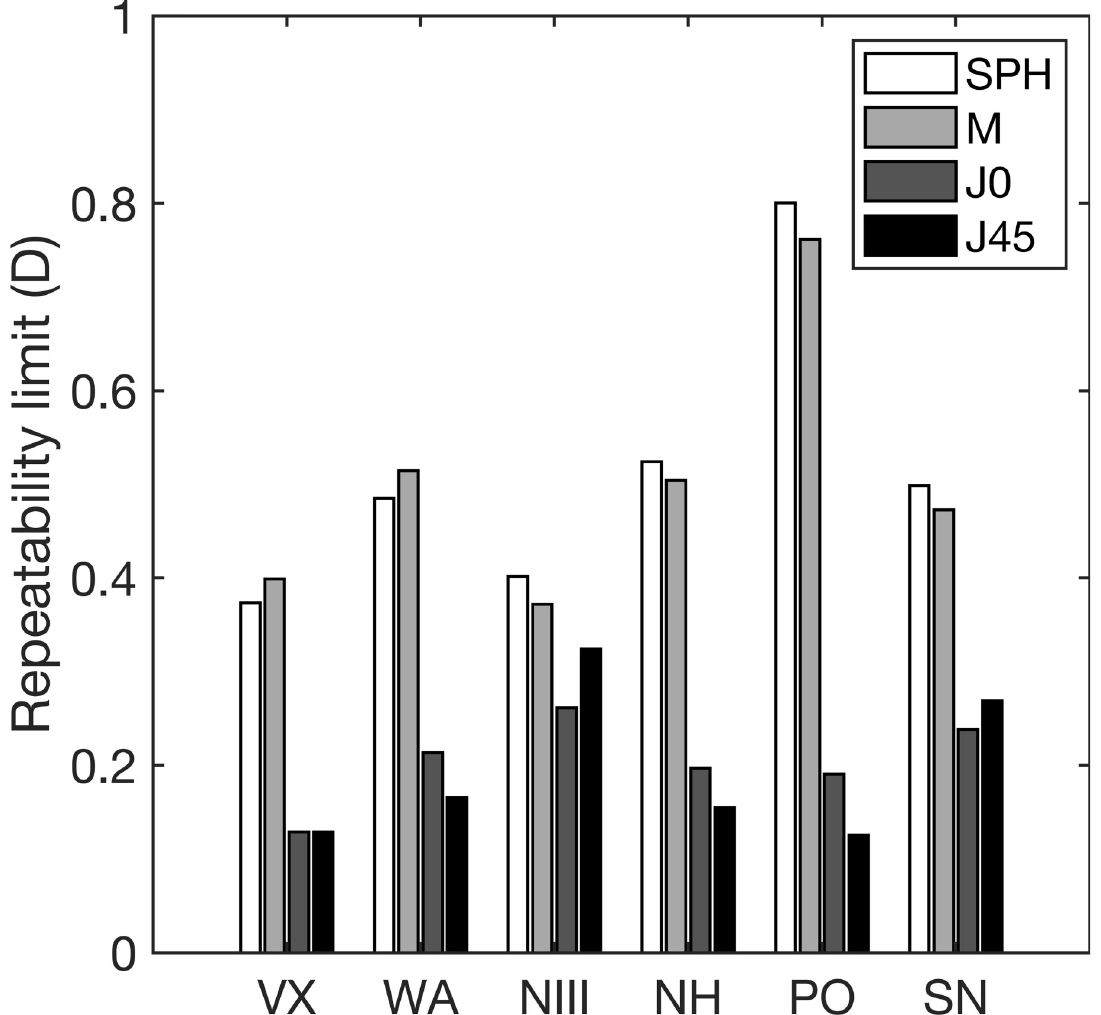
Fig 1. Repeatability limit for the measurements of sphere, spherical equivalent and the cylindrical vector components. SPH: Sphere, M: Spherical equivalent, J0 and J45: cylindrical vector components, VX: Eye Refract, WA: WaveAnalyzer 700, NIII: TONOREF ™ III, NH: Handheld ref/keratometer HandyRef-K, PO: PlusoptiX A12C, SN:NVision-K